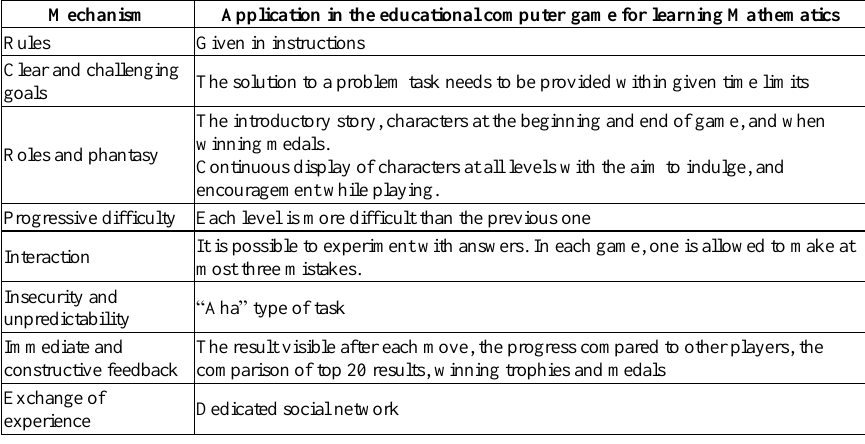
Table 1. The mechanisms applied in learning through educational computer games